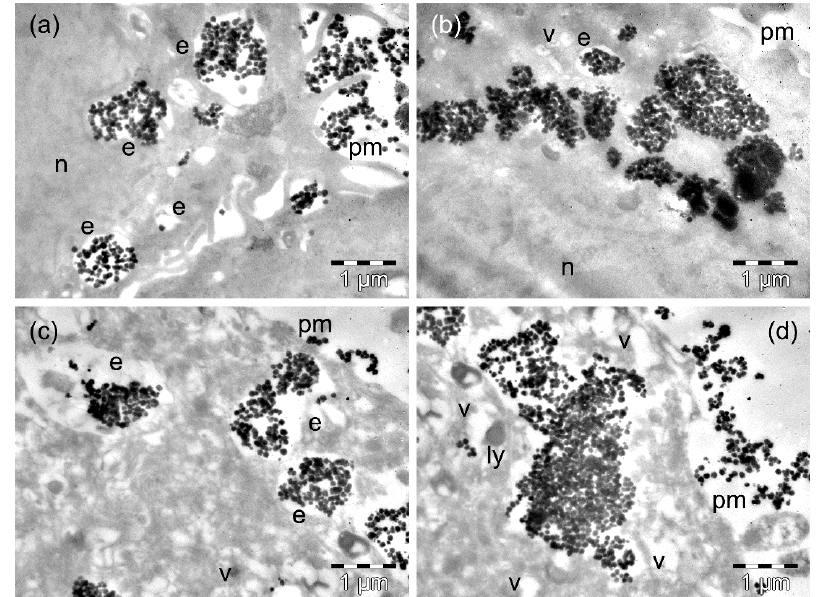
Figure 7. TEM images of D407 cells containing ZnFe 3 O 4 MNPs after 4 h ( a , b ) and 24 h ( c,d ) of incubation time. The letters n, e, v, ly, and pm denote the nucleus, the endosomes, the vacuoles, the lysosomes, and the plasma membranes, respectively.